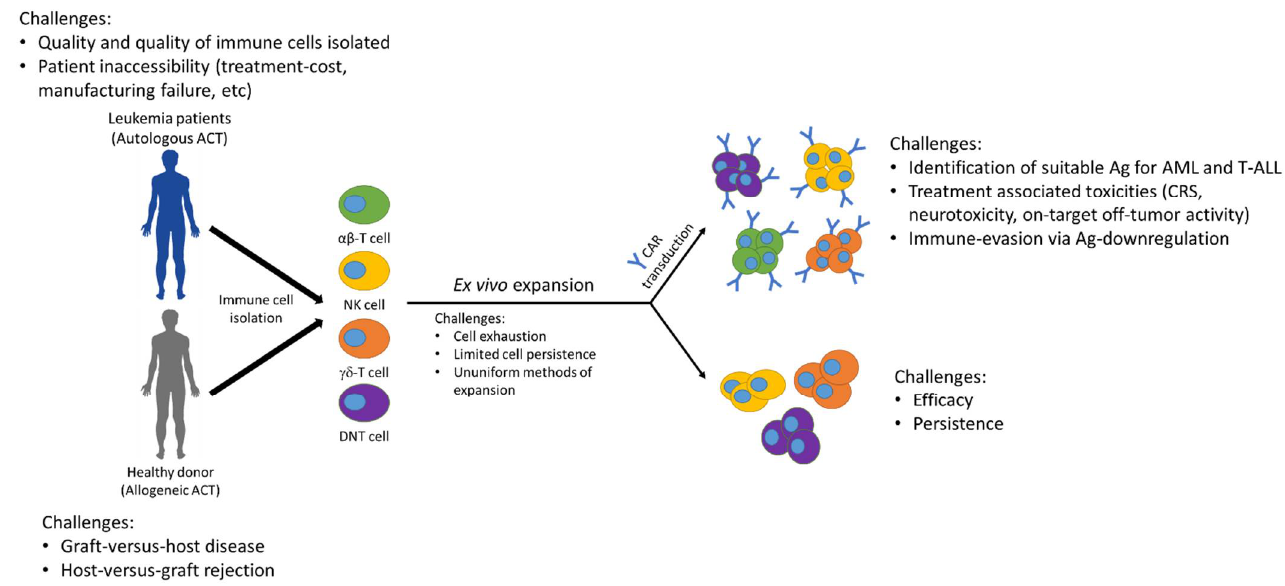
Figure 3. Current challenges using ACT to treat acute leukemia.